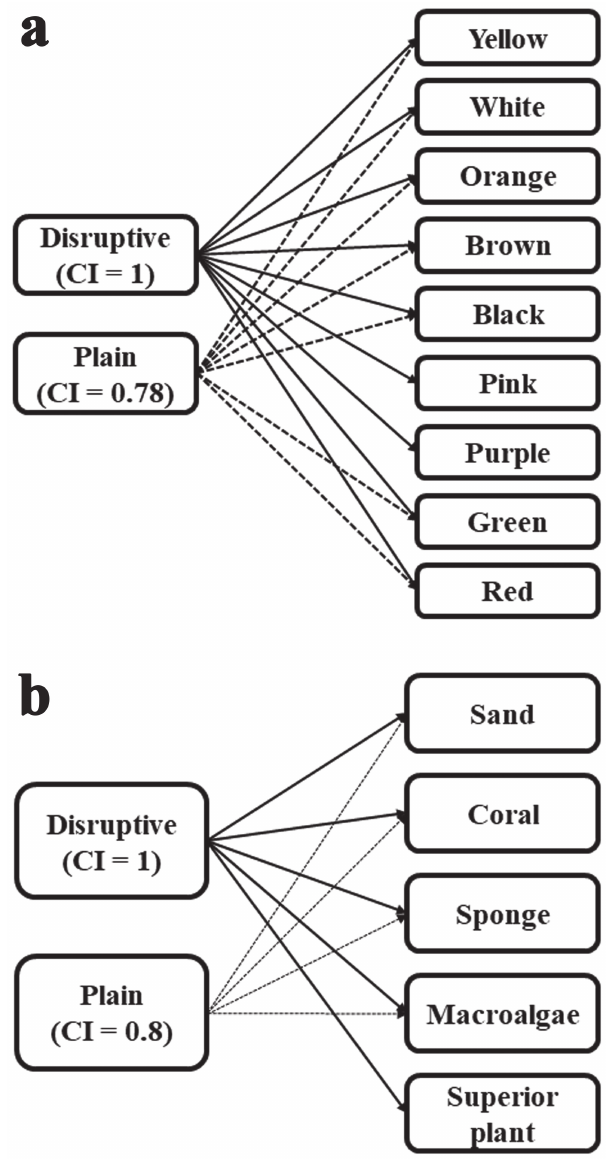
Fig. 3. Connectance of the two seahorse Hippocampus reidi color morphs to the background color ( a ) and holdfast ( b